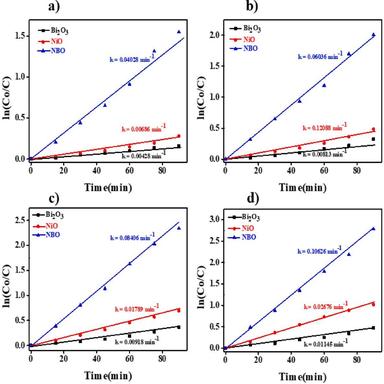
Kinetic plot for MO dye photodegradation various concentration dye a) 20 ppm, b) 15 ppm, c) 10 ppm, d) 5 ppm.